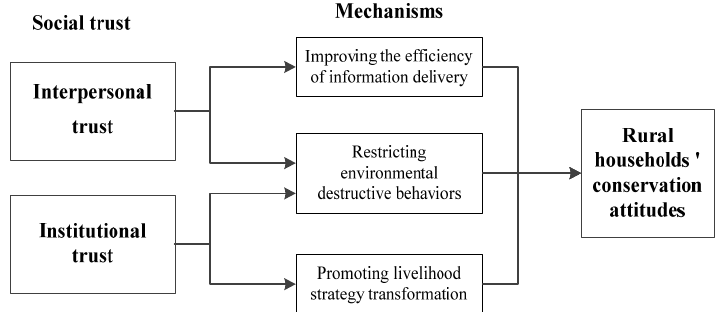
Figure 1. The theoretical framework of the impact of rural households’ social trust on their conservation attitudes.